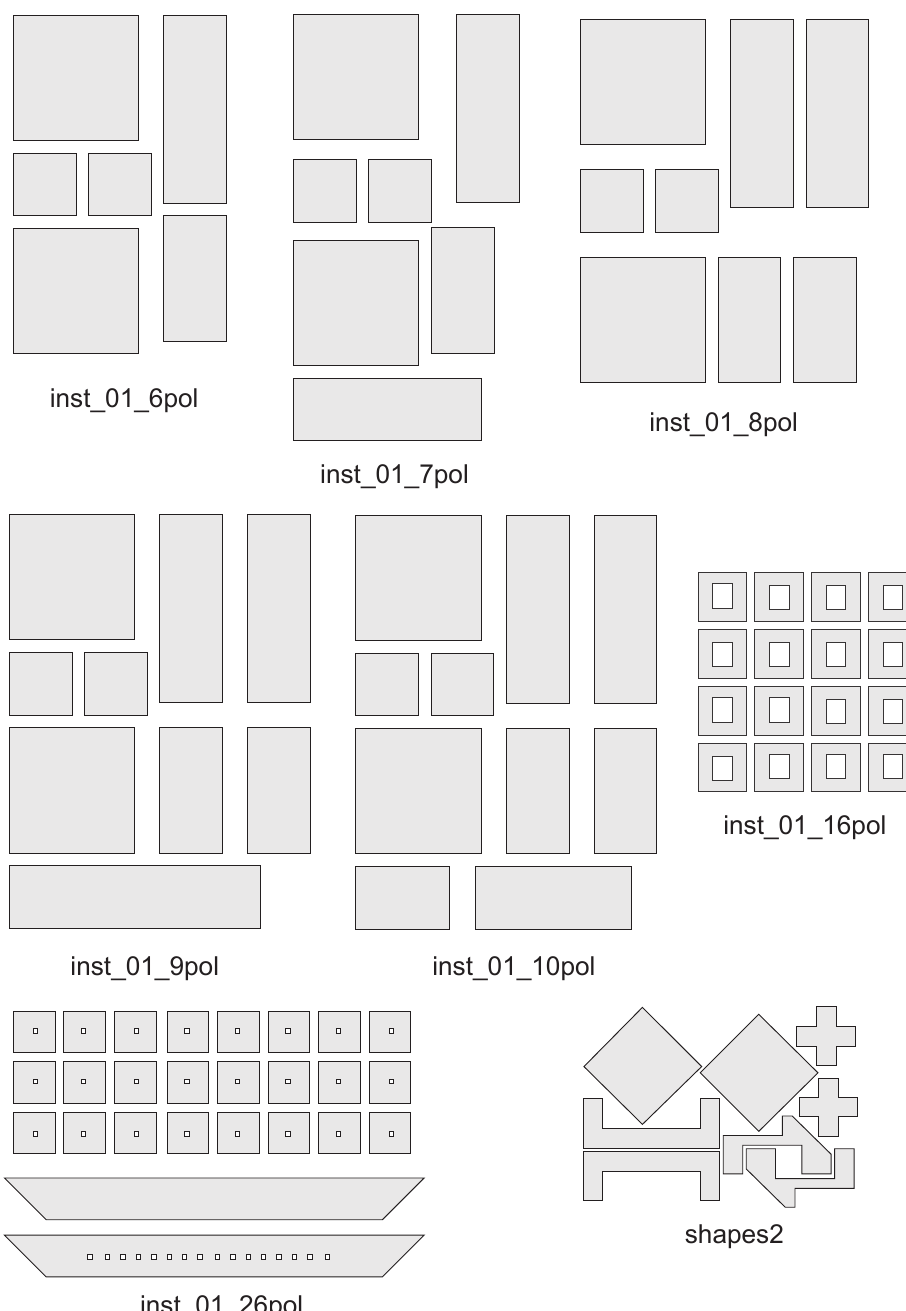
Figure A4. Second batch of instances with separated